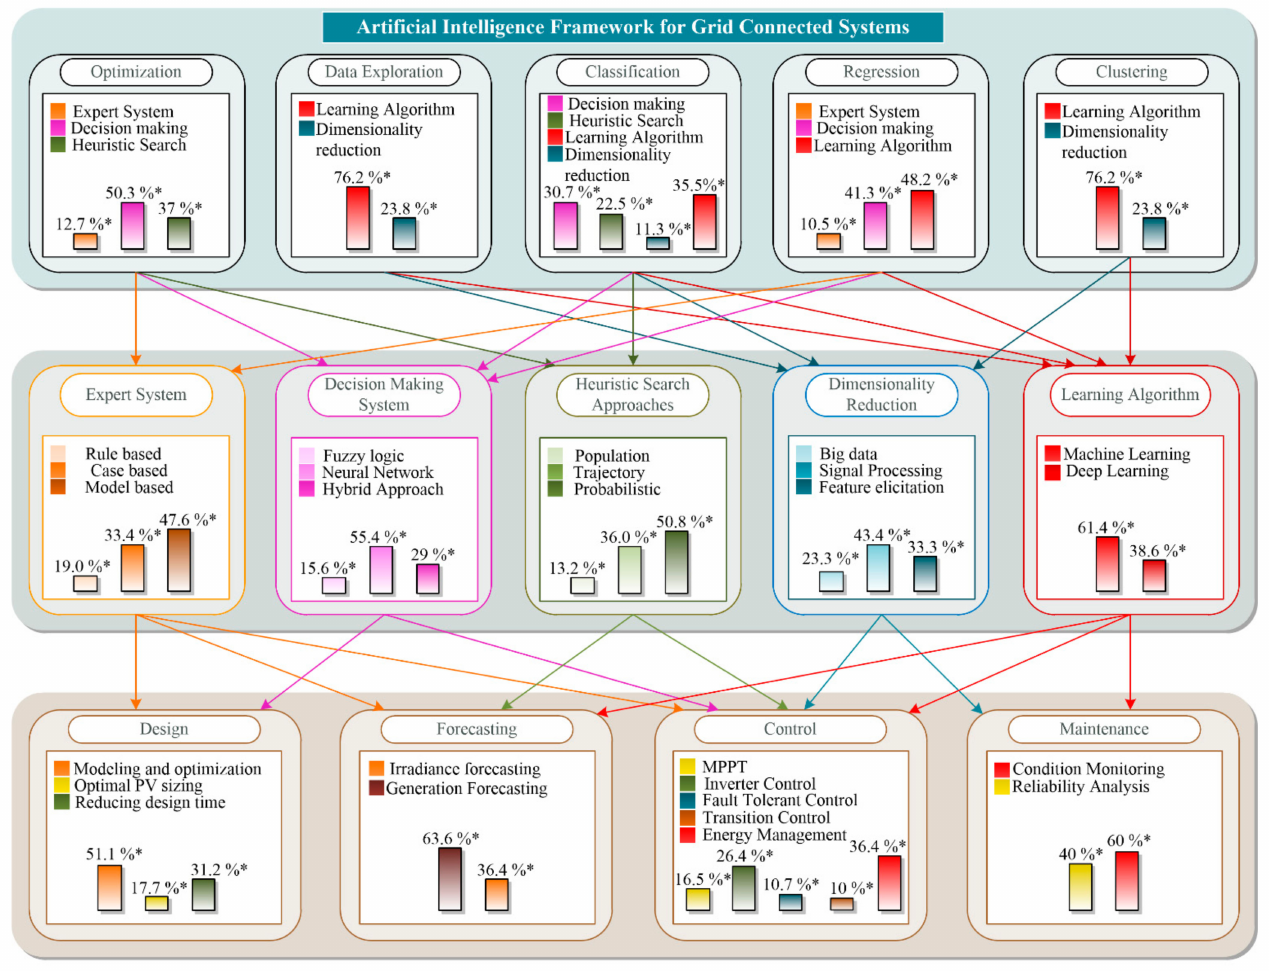
Figure 3. AI framework for different functions, and techniques in application with grid-connected PV